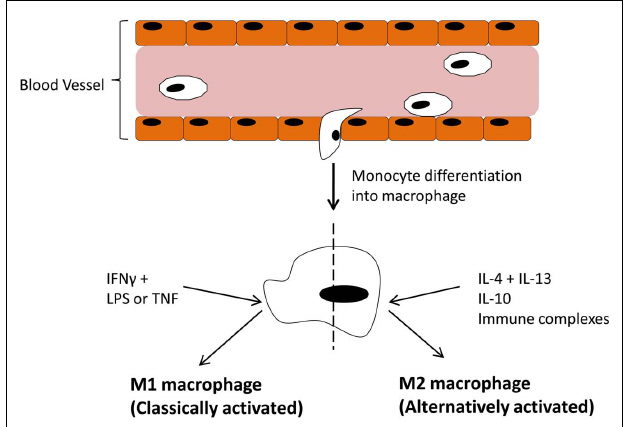
FIGURE 1 | Blood-borne monocytes exit the blood stream and differentiate into macrophages. The macrophage response depends on the stimulus provided by the microenvironment. IFN γ along with LPS or TNF α drive polarization of M1 (classically activated) macrophages which participate in pro-inflammatory activities. On the other hand, IL-4 + IL-13, IL-10, or immune complexes drive M2 (alternatively activated) macrophages, which participate in anti-inflammatory